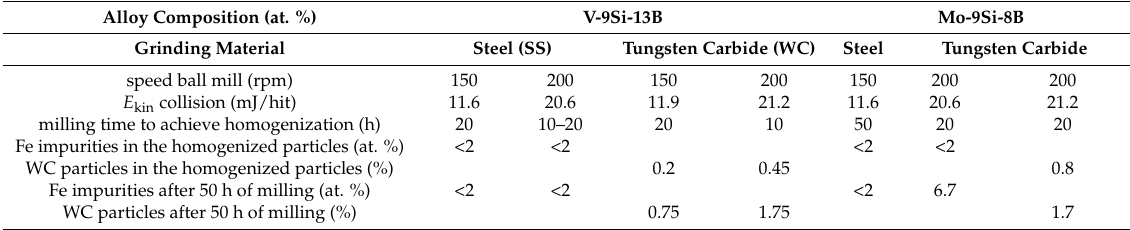
Table 1. Milling conditions, process parameters and energy of collision after Abdellaoui and Gaffet [37], in V-9Si-13B and Mo-9Si-8B powders.